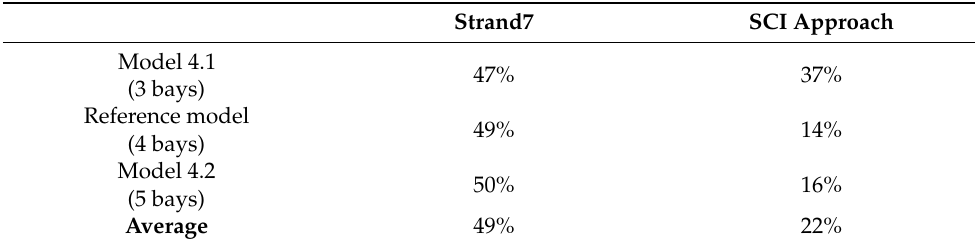
Table 17. Possible error between different approaches (change in a number of bays).